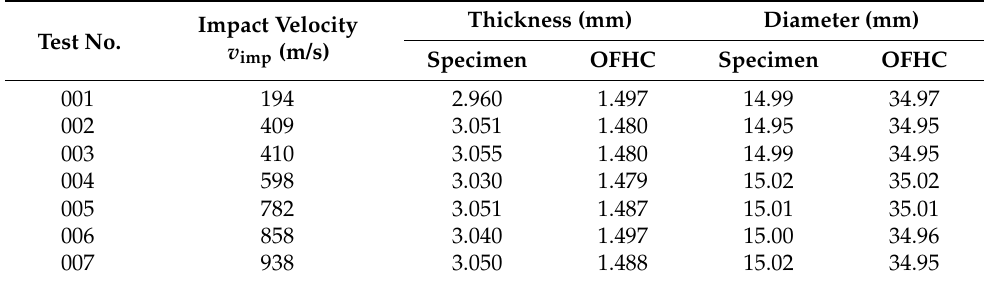
Table 2. Experimental details of the plate impact